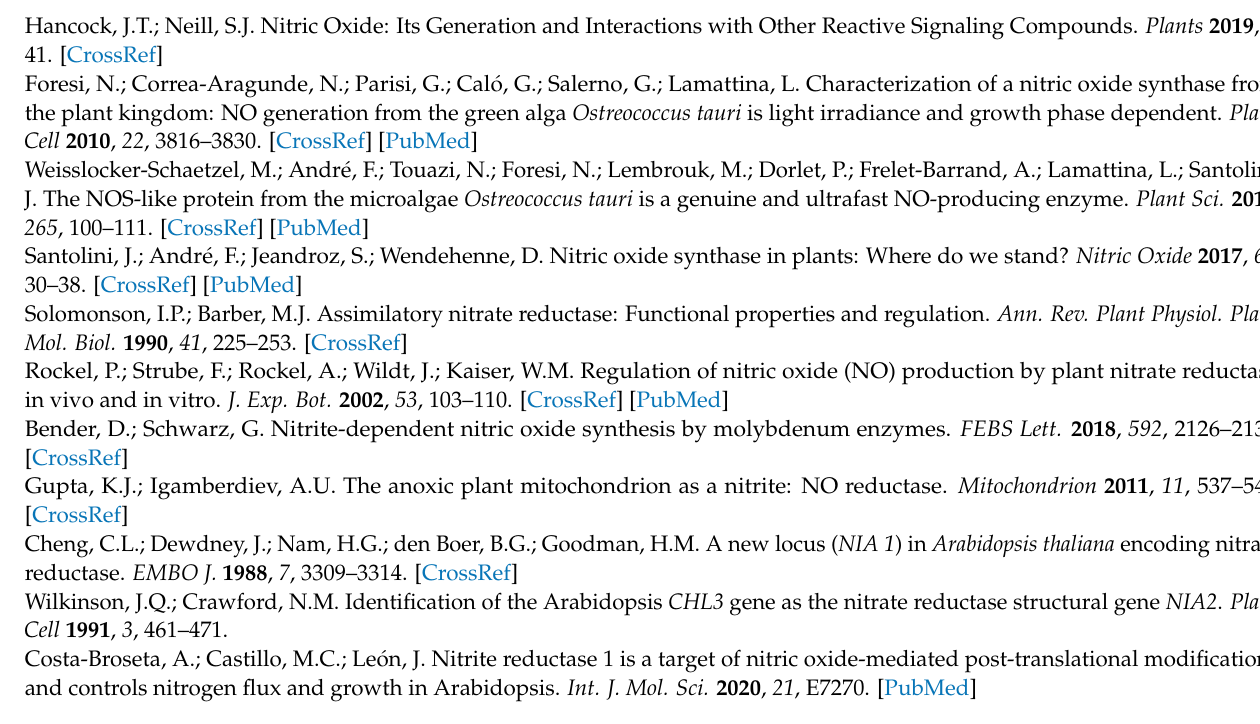
NIA1 and NIA2; Figure S3: Effect of NO and proteasome inhibitor MG132 on NR protein (a) and NIA1/NR1 and NIA2/NR2 transcript levels (b). 12-day old seedlings were treated with 0.2 mM MG132 and/or exposed to a 300 ppm NO pulse for 5 min as indicated. Samples for protein and RNA extraction were collected by 1 h after treatments. Transcript levels are relative to those detected in untreated plants (Control) and represent the mean of three independent replicates ± standard error. Table S1: Genes similarly regulated in NO-treated wild type and untreated NO-deficient mutant plants; Table S2: List of peptides identified in 35S:3xHA-NIA1 plants carrying a single nitration, S-nitrosation or ubiquitylation; Table S3: List of peptides identified in 35S:3xHA-NIA2 plants carrying a single nitration, S-nitrosation or ubiquitylation; Table S4: Oligonucleotides used in this work; Supplementary Materials and